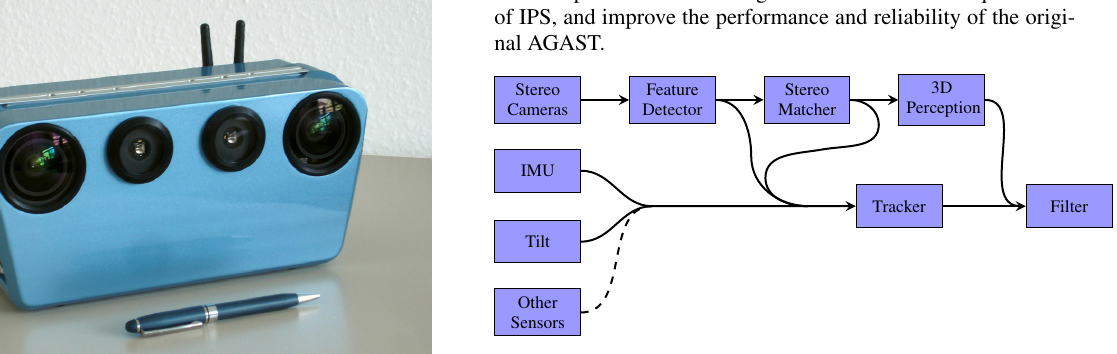
Figure 2: The data flow of IPS